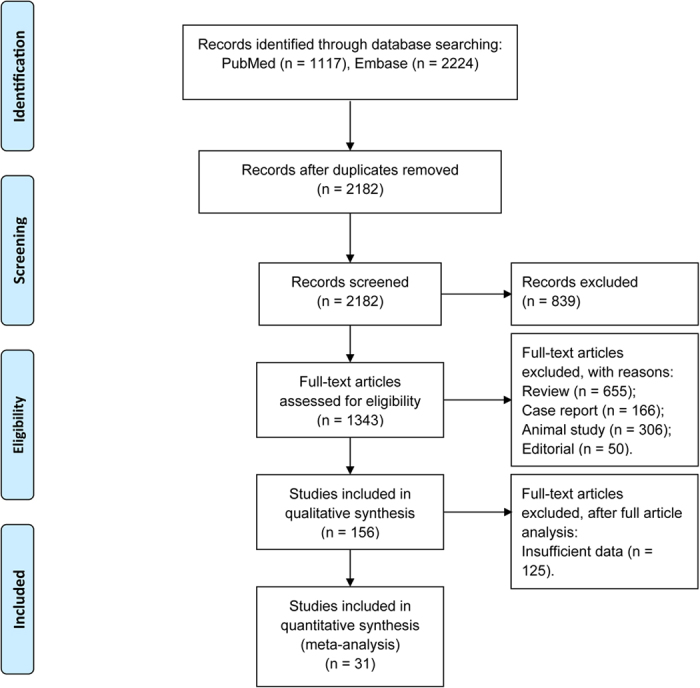
Study flow chart.